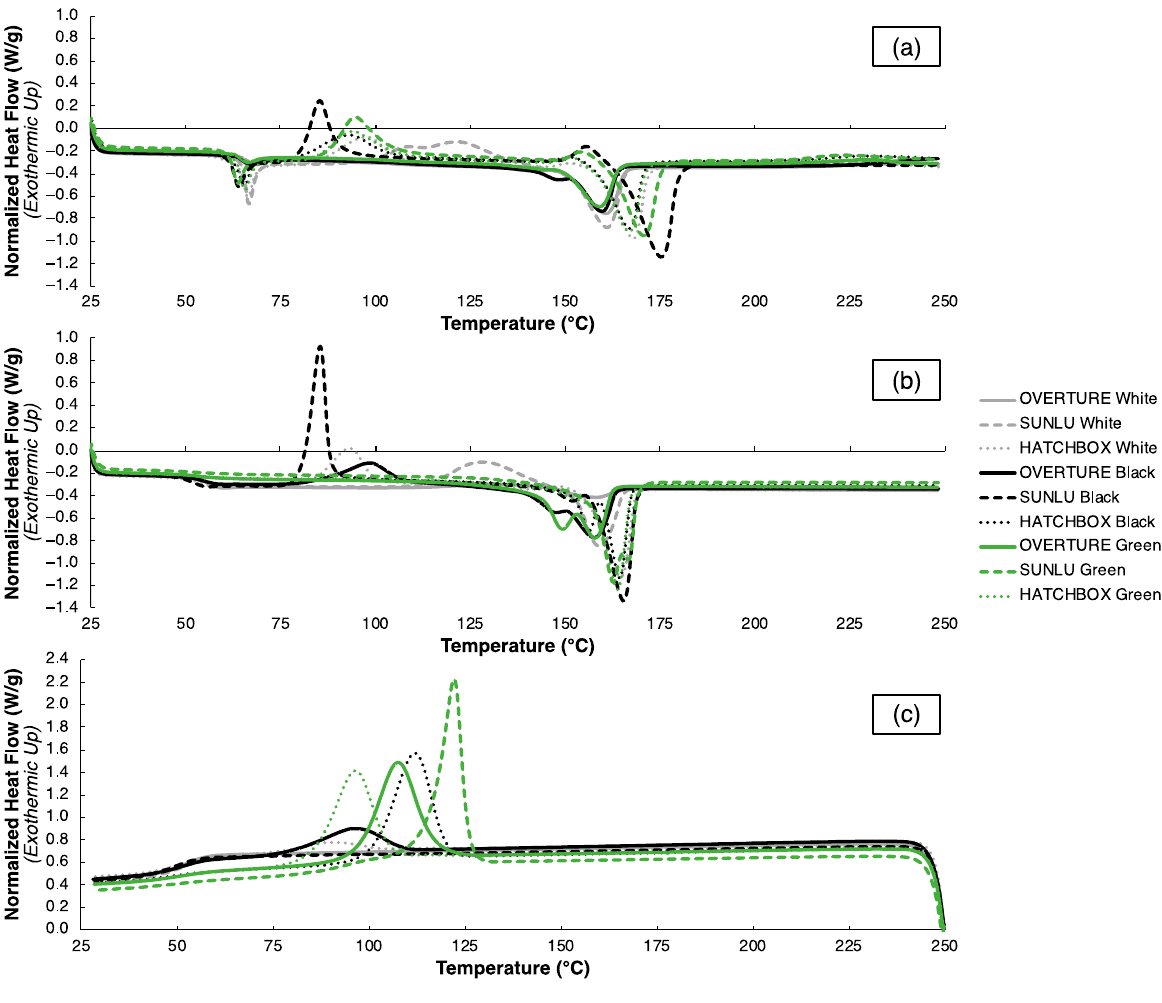
Figure 6. DSC curves for all nine filaments upon heating in the ( a ) as-fabricated and ( b ) normalized states from DSC Runs #1 and #2, respectively, and ( c ) upon cooling between Runs #1 and #2.